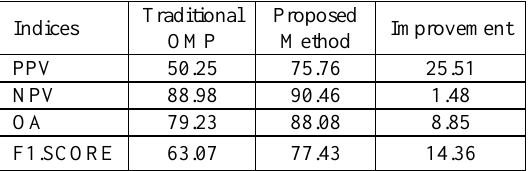
Table (2). Statistical indices related to accuracy assessment of labeling for the simulated